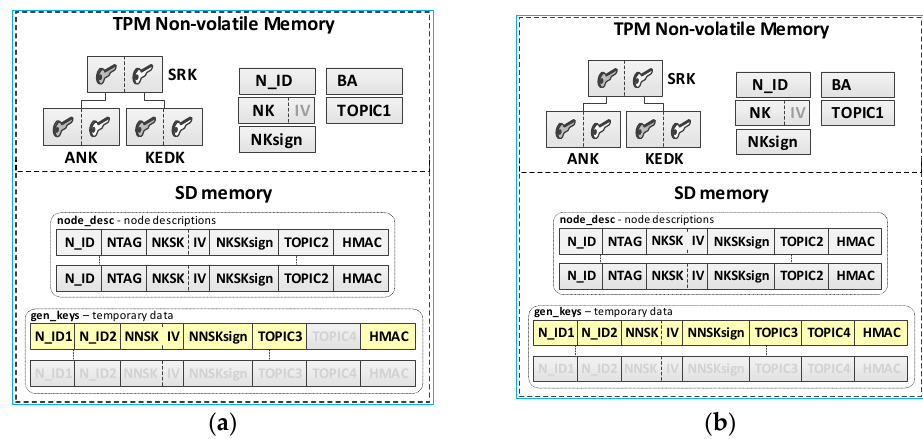
Figure 22. The content of data stored by the KS node after the step (3) ( a ) and after the step (5) ( b ).